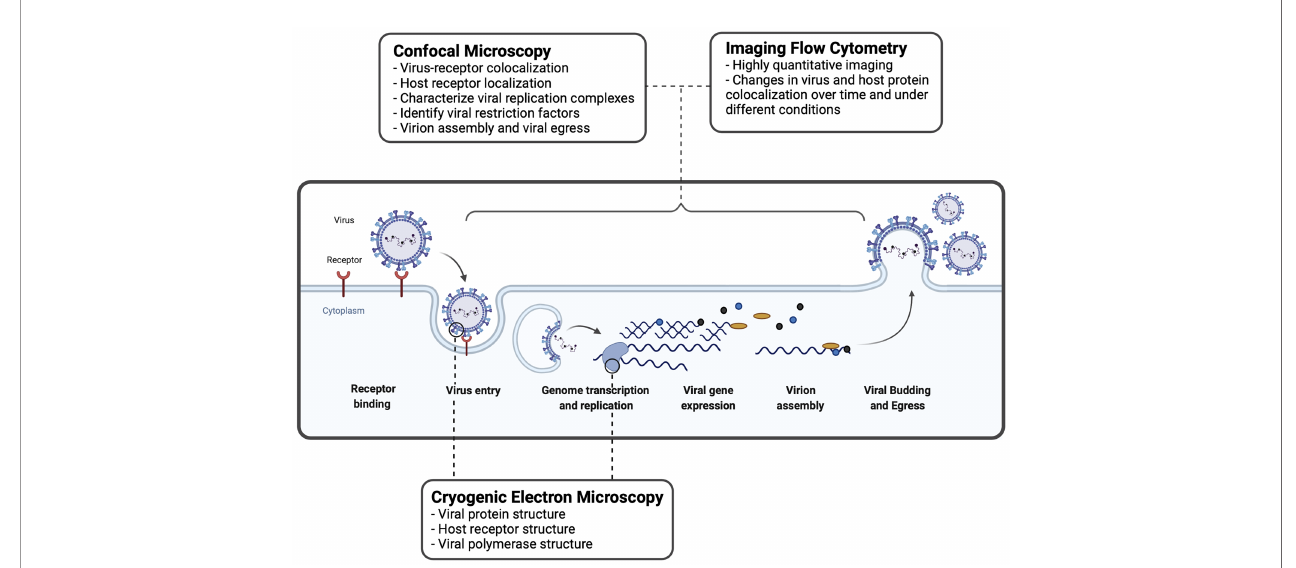
FIGURE 2 | Imaging techniques used to study virus-host interactions during the viral replication cycle. A basic viral replication cycle for RSV, an enveloped -ssRNA virus, is shown. All viruses follow the general principles of cellular entry, genomic replication, virion assembly, and virion release during a productive infectious cycle. Confocal microscopy, imaging fl ow cytometry, and cryogenic electron microscopy are three common imaging techniques used within the study of virology to assess interactions between virus and host